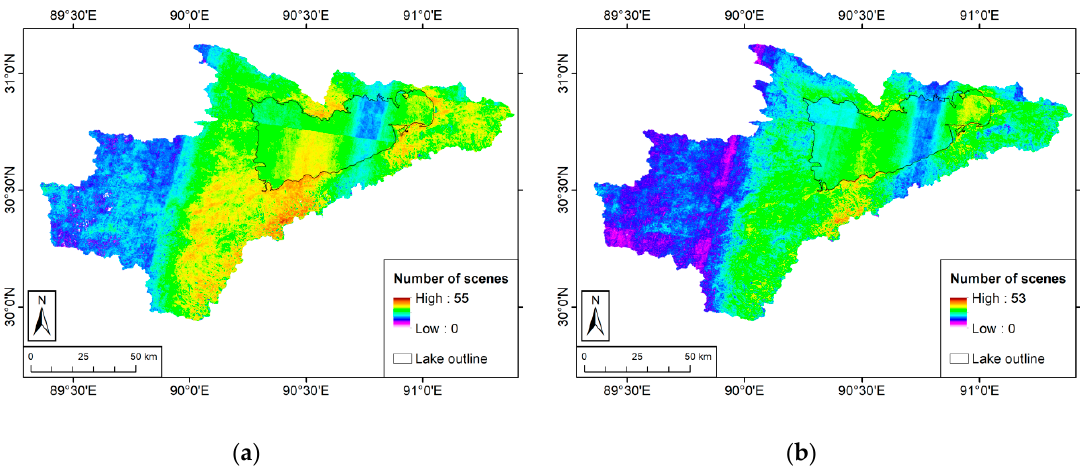
Figure 2. Quality Indicator for Nam Co area as number of scenes for: ( a ) ASTER GDEM1 30 m (©METI & NASA 2009); ( b ) GDEM2 30 m (©METI & NASA 2011). While the western portion of the